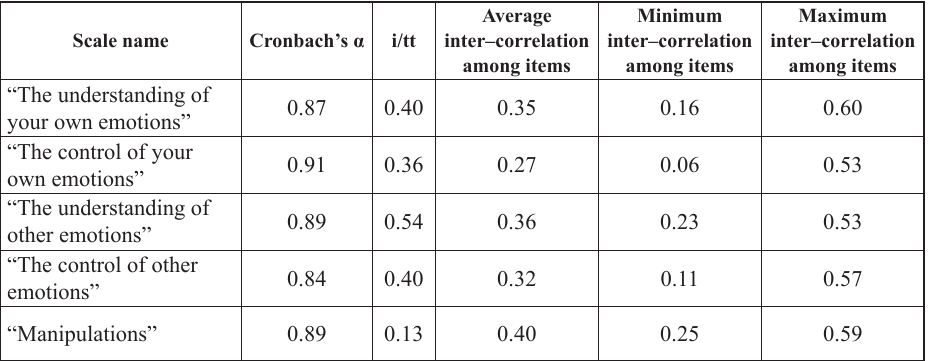
Table 1. The internal consistency of the EI- DARL-V1 measurement technique